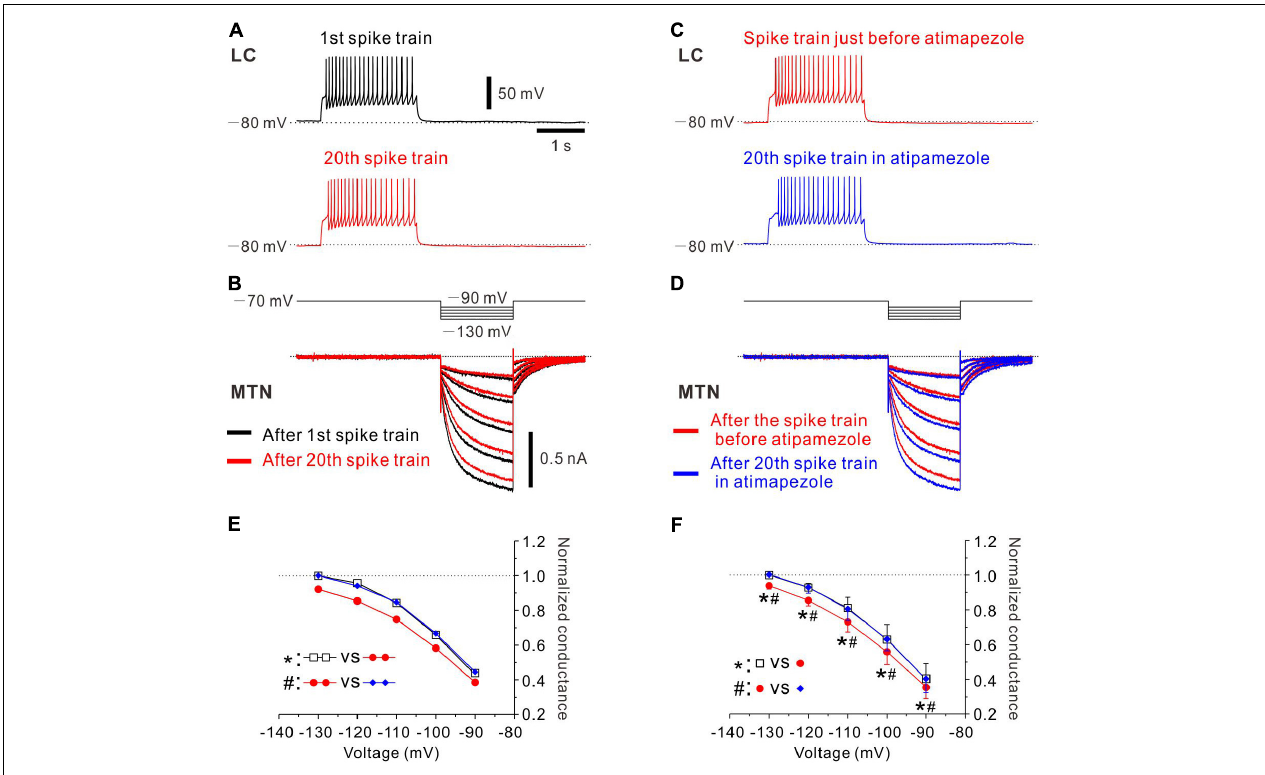
FIGURE 3 | Effects of atipamezole on inhibition of Ih evoked in an MTN neuron by the spike activity of single LC neuron. (A) Black trace represents a train of spikes at 20 Hz which was induced in an LC neuron after recording of control Ih responses in an MTN neuron (1st spike train). Red trace represents 20th spike train. (B) Superimposed traces of Ih responses evoked by negative voltage pulses stepped from –70 to –90 up to –130 mV by 10 mV step in an MTN neuron obtained before 1st spike train (black trace), and those obtained after evoking 20th spike train (red trace) induced in a simultaneously recorded LC neuron. (C) Red trace represents the 20th spike train. Blue trace represents 20th spike train in the presence of atipamezole. (D) Superimposed traces of Ih responses evoked by negative voltage pulses obtained after evoking 20th spike train (red trace) and those obtained after evoking 20th spike train in the presence of atipamezole (blue trace). (E) Plotting of voltage and normalized conductance of Ih obtained before 1st spike train (black square), after 20th spike train (red circle), and after 20th spike train in the presence of atipamezole (blue diamond) in one paired recording. Two-way ANOVA: p < 0.001, followed by Bonferroni post hoc test, * p < 0.001, and # p < 0.001. (F) Plotting of voltage and normalized conductance of Ih in a total of four paired recordings. Two-way repeated measures ANOVA: p = 0.006, followed by Bonferroni post hoc test, * p < 0.002 (the largest p -value is 0.0015) and # p < 0.001 (the largest p -value is